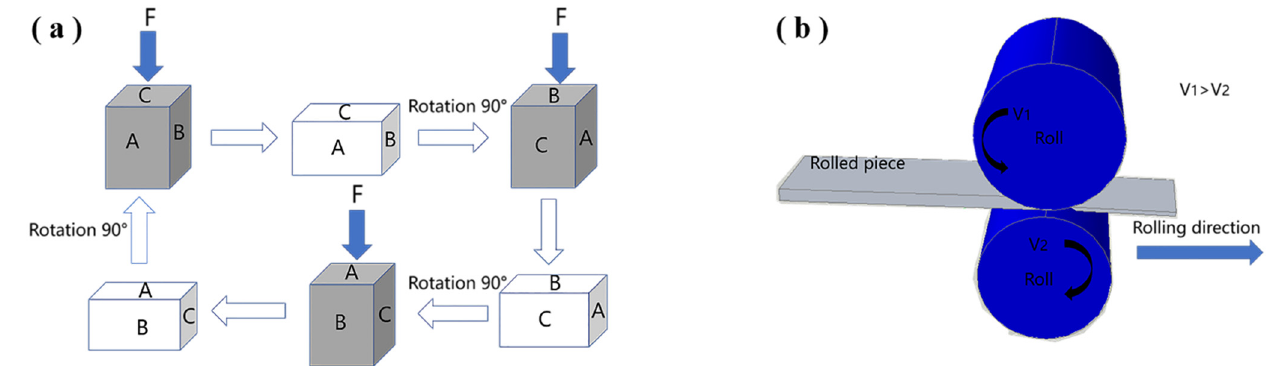
Figure 1. The schematic sketch of ( a ) multidirectional forging and ( b ) asymmetrical rolling. A, B, and C are pressing planes. F is the force.